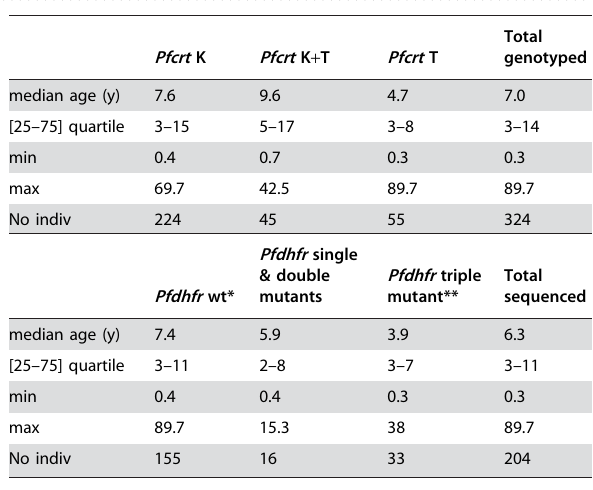
Table 2. Age association of mutant Pfcrt and